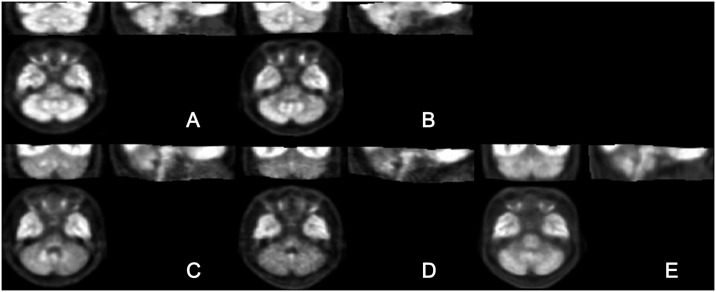
Representative images of spatially normalized ratios using study-specific templates of normal controls (A) and patients with crossed cerebellar diaschisis (B), multiple system atrophy of the cerebellar type (C), Spinocerebellar Ataxia (SCA) type 2 (D), and SCA type 6 (E).